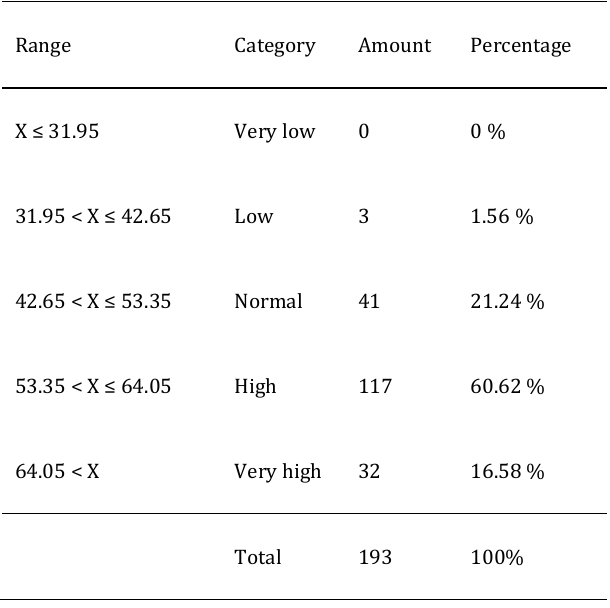
Table 10 The categorization score of readiness for